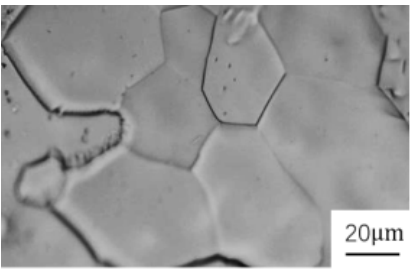
Figure 3: Change of lattice constant for β (Zr, Nb) phase without and with HCPEB treatment